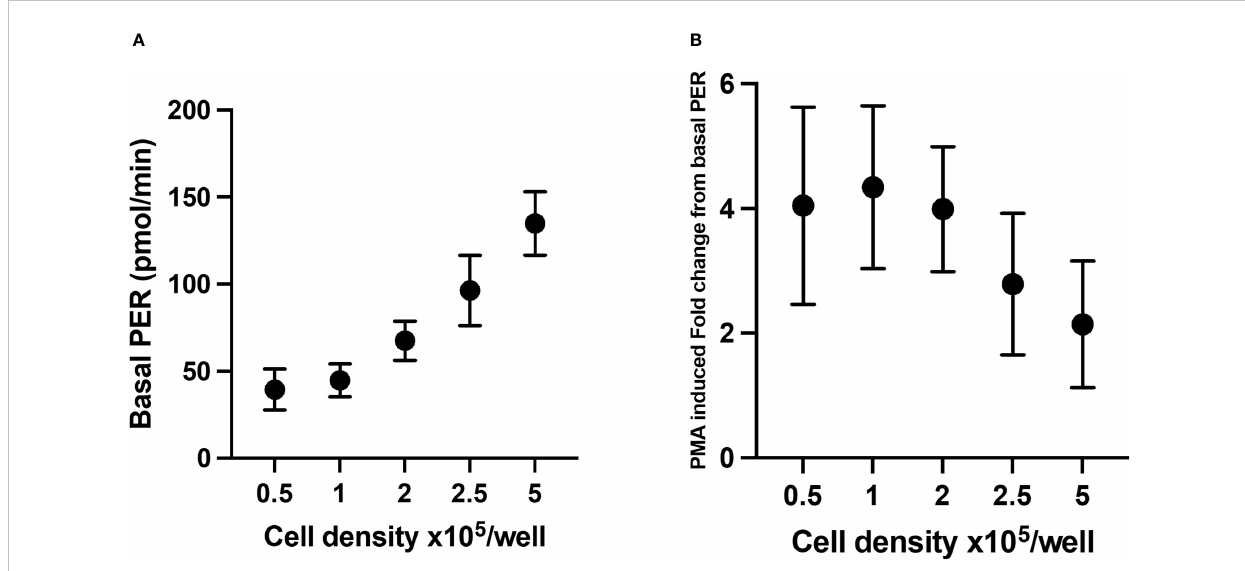
FIGURE 6 Glycolytic parameters from neutrophils seeded at different densities. Glycolytic rates of isolated neutrophils seeded at 0.5, 1.0, 2.0, 2.5 and 5 x 10 5 cells/well were established from proton ef fl ux rate (PER) data as described previously. Basal glycolysis (A) represents fi nal baseline measurement of glycolysis prior to stimulation, (B) phorbol 12-myristate 13-acetate (PMA)-induced fold change from basal PER. Data represent means ± standard error of the mean (SEM) from 3 distinct